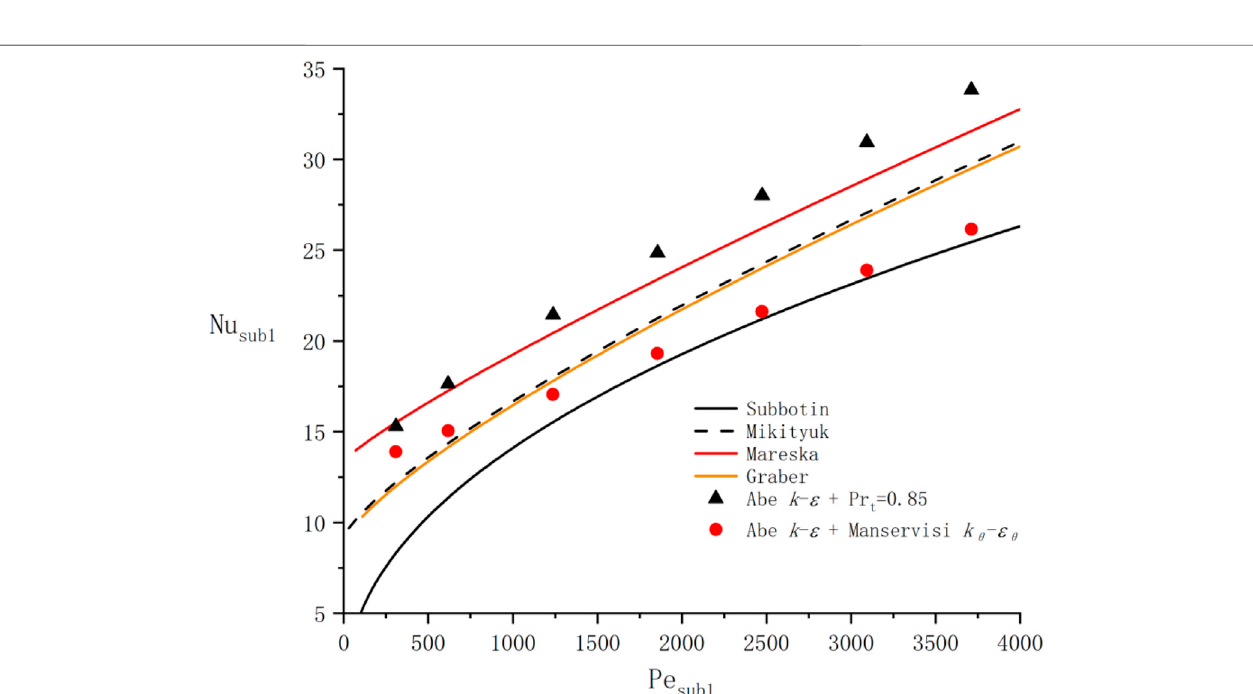
FIGURE 12 | Comparison of Nu sub 1 calculated by different turbulent heat transfer models.